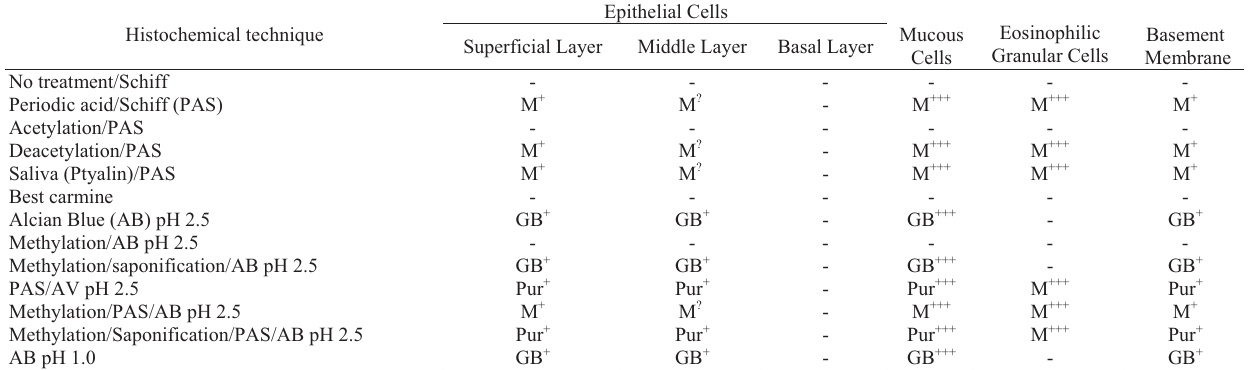
Table 2. Summary of histochemical reactions of the carbohydrate moieties in different cell types of Ancistrus dolichopterus epidermis at the dorsal part of the body. Symbols: GB, greenish blue; M, magenta; Pur, purple; R, red; -, negative reaction; ±, weak; +, moderate; ++, strong; +++, very strong